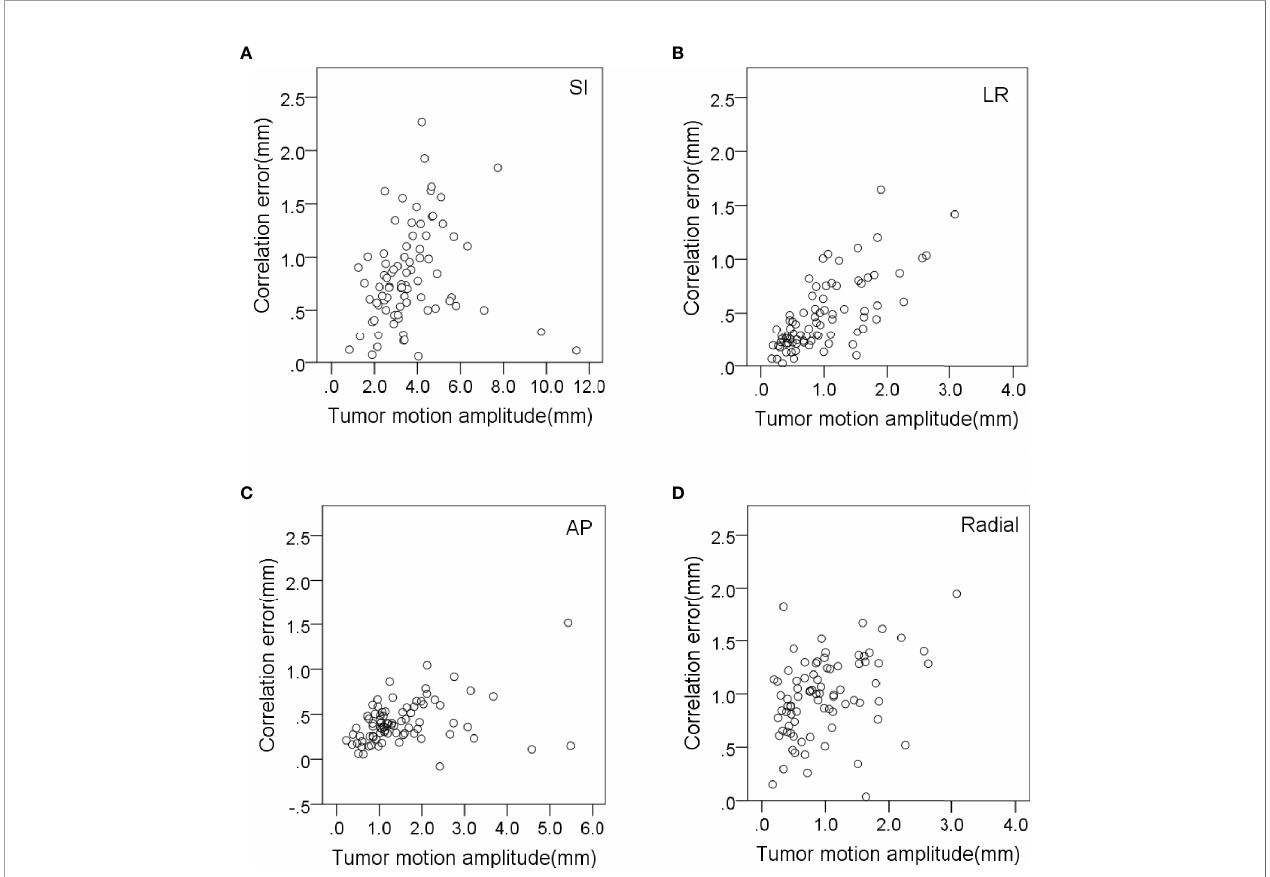
FIGURE 3 | Variation of correlation errors with tumor motion amplitude in (A) SI, (B) LR, (C) AP and (D) radial